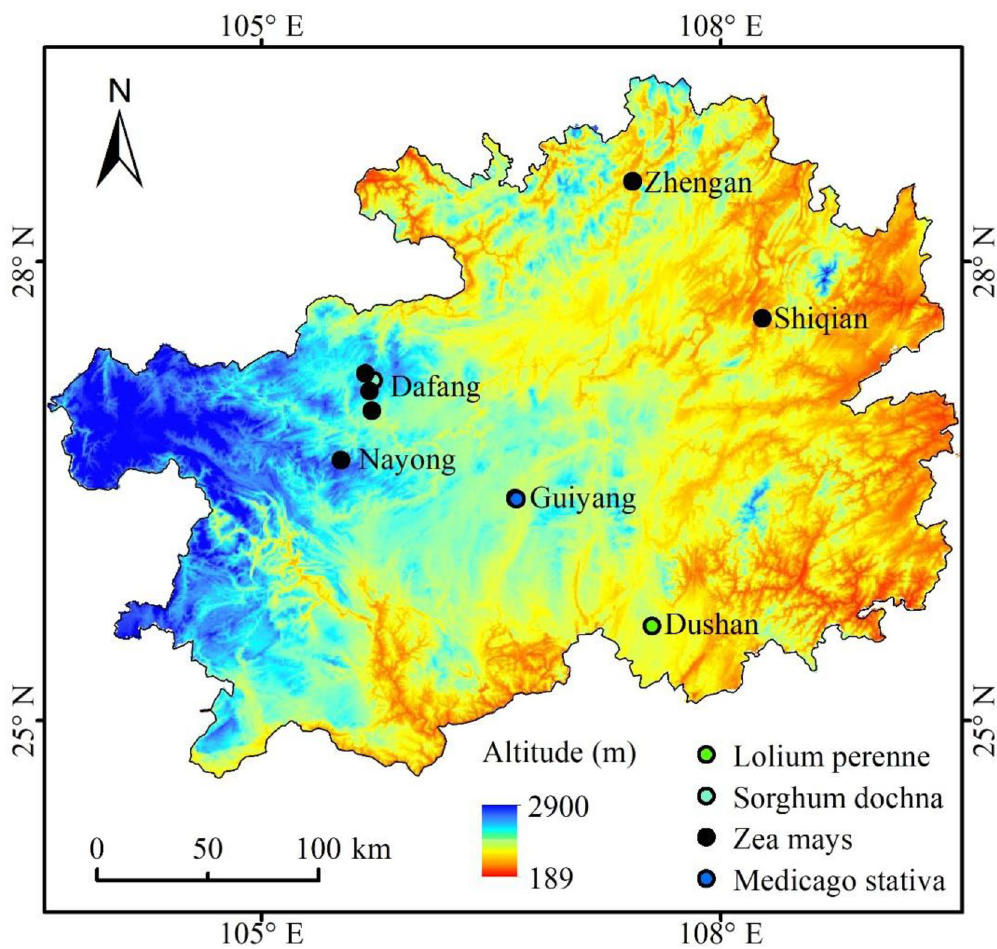
Figure 1. The silage materials, longitude, latitude and altitude of sampling sites. Note The map was generated by Arcmap 10.8 software (https:// links. esri. com/ open- source- ackno wledg ments).